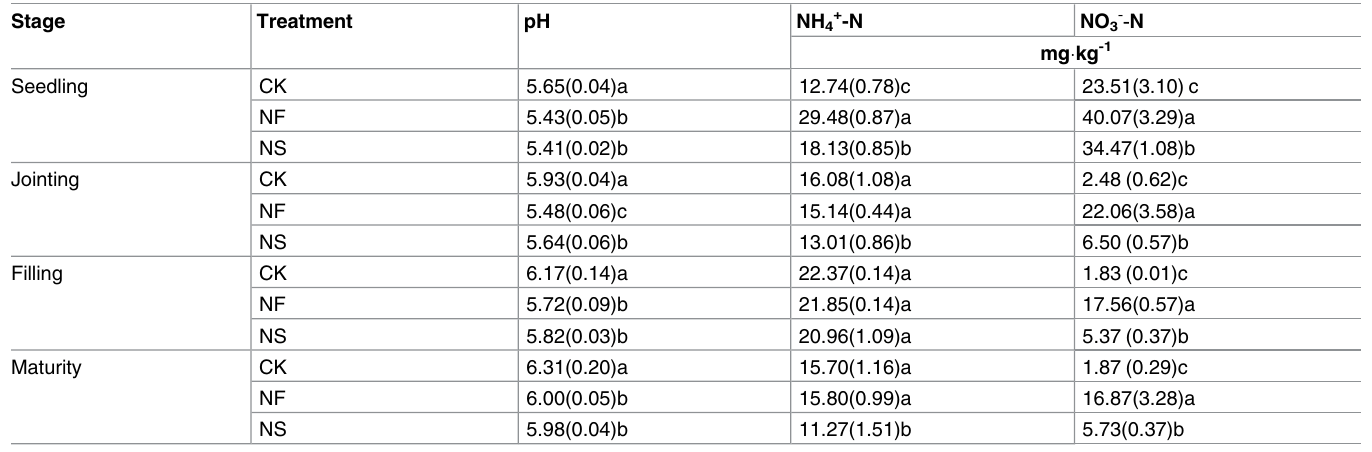
Table 1. Soil chemical properties (means ± S.D., n =